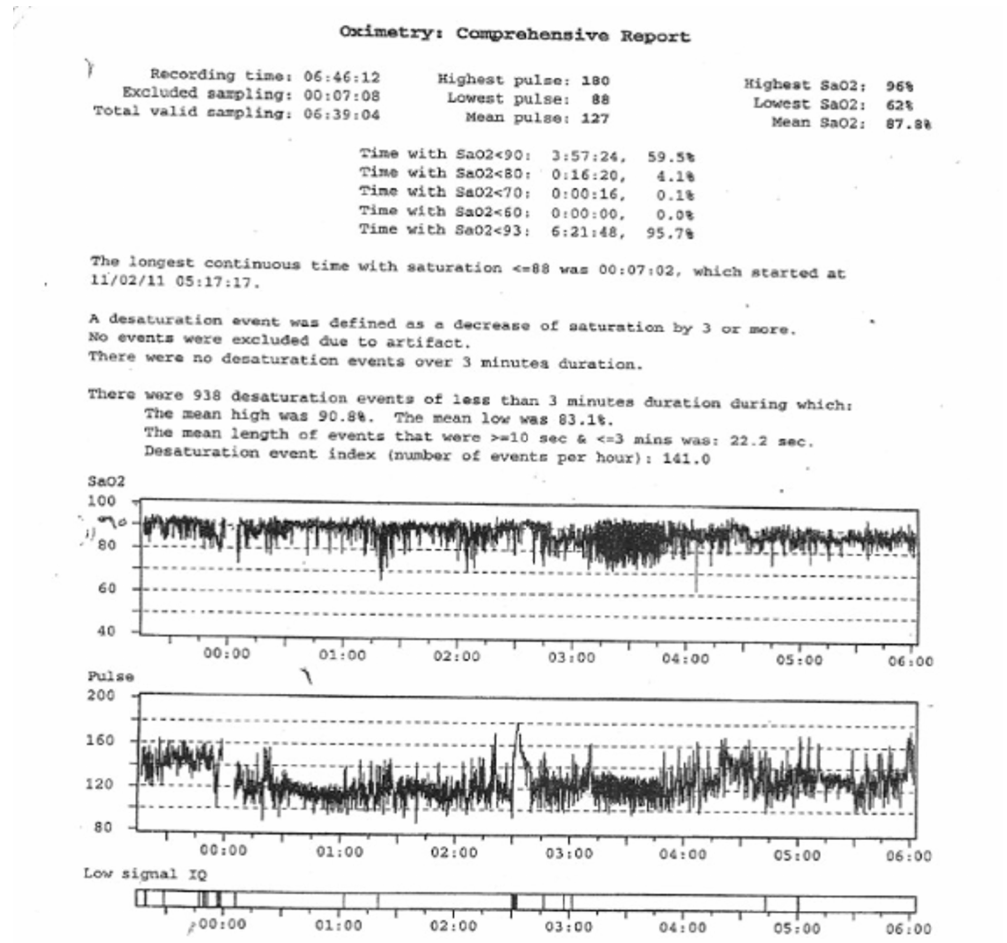
Figure 6. Overnight oximetry demonstrating low baseline oxygen saturation and frequent oxygen desaturations suggestive of hypoventilation.